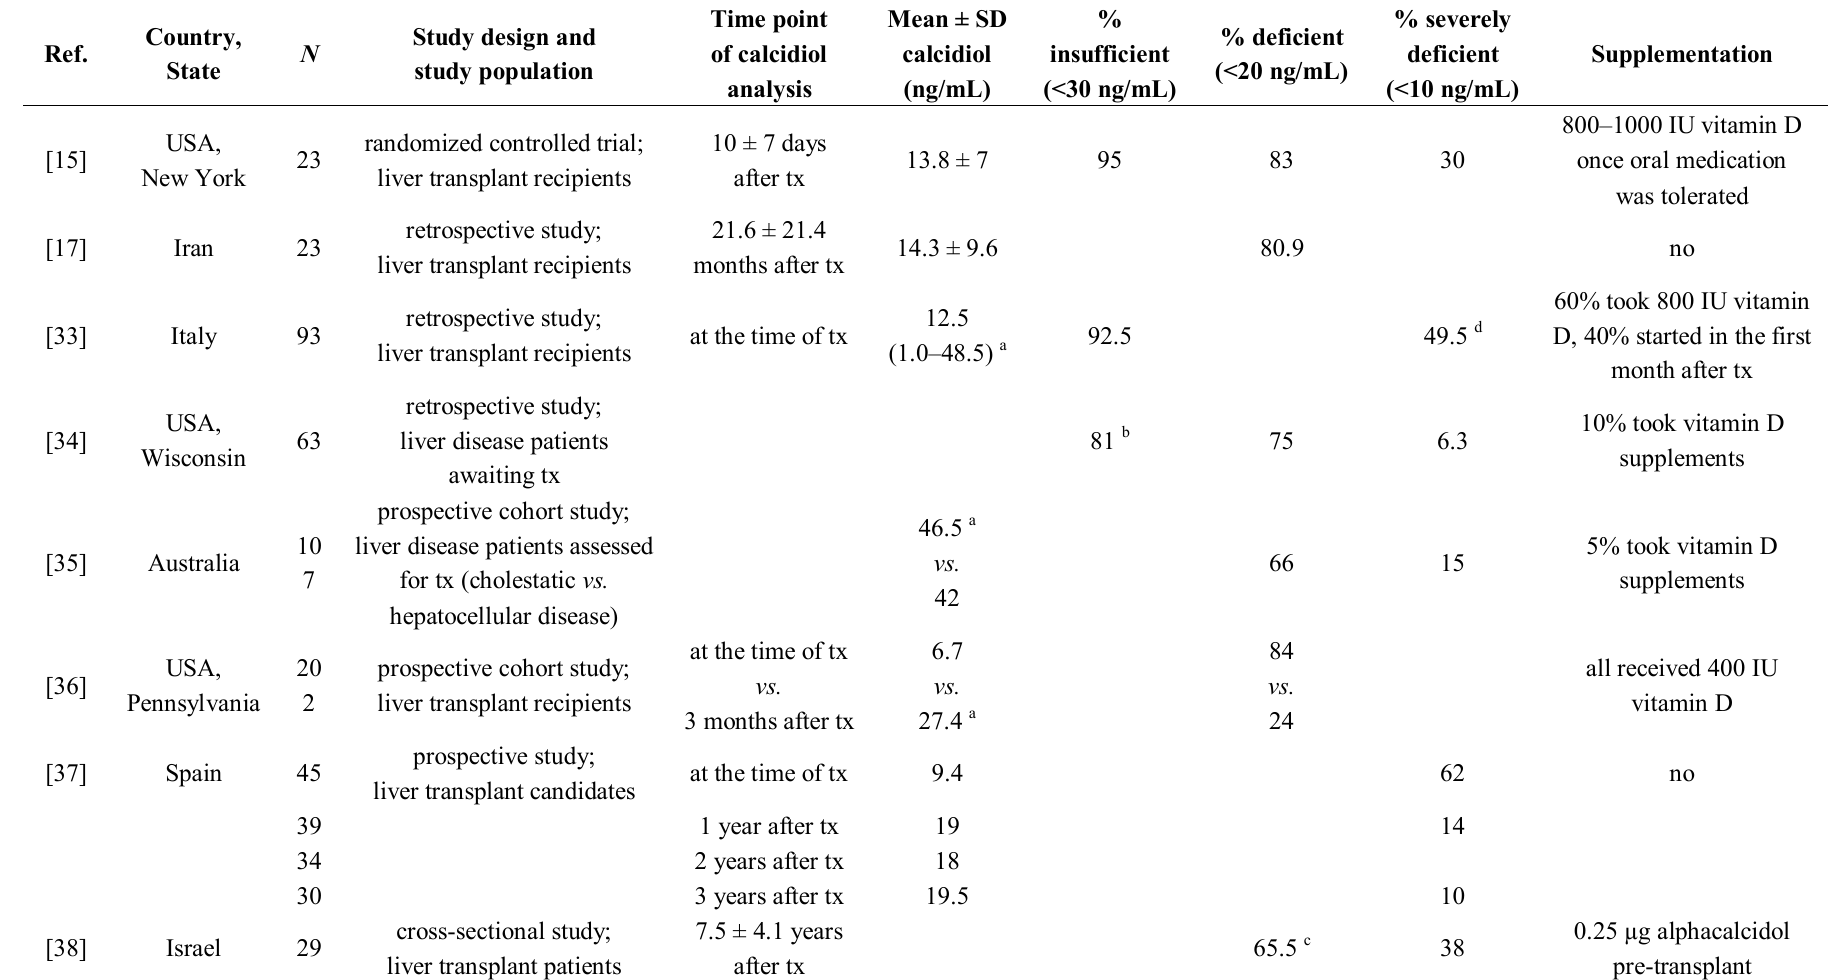
Table 3. Vitamin D status in end-stage liver disease and liver transplant patients.